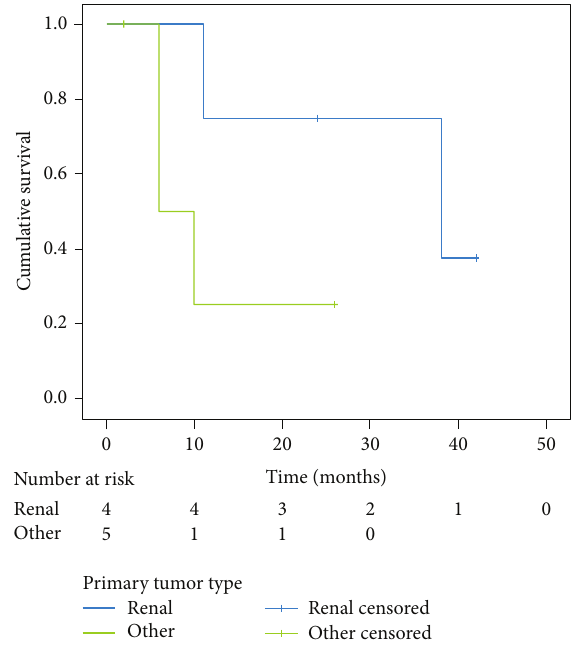
Figure4:Kaplan-Meiersurvivalcurveofsubgroupsofpatientswith different origin of metastases (kidney versus other); 𝑃 = 0,103 .